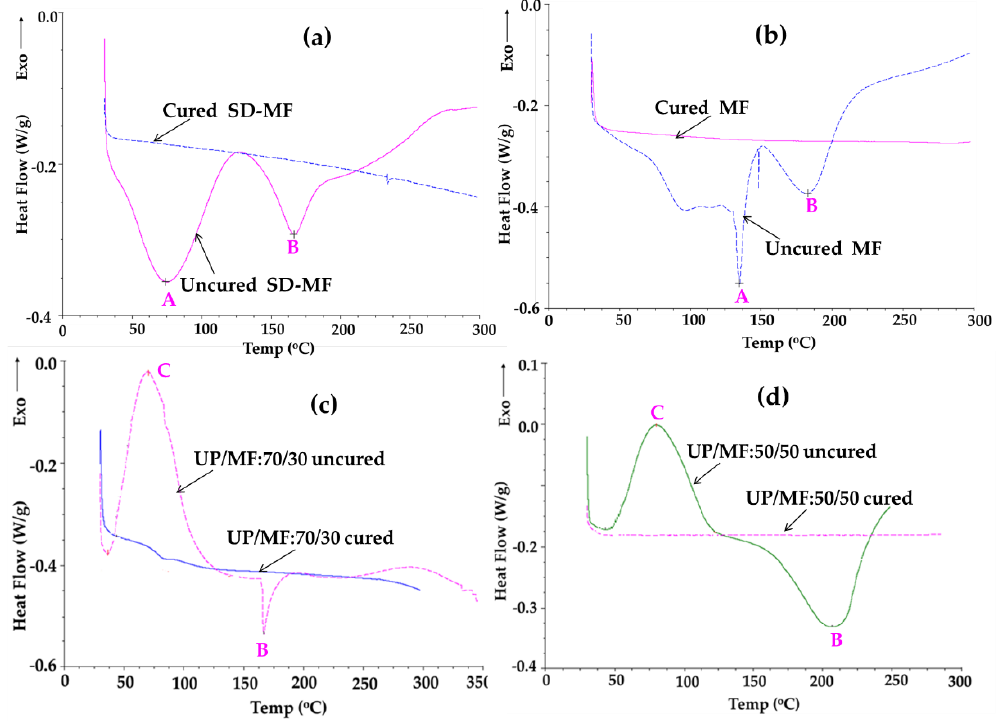
Figure 1. DSC curves of uncured and cured ( a ) SD-MF powder, ( b ) MF, ( c ) UP/MF:70/30, and ( d ) UP/MF:50/50.